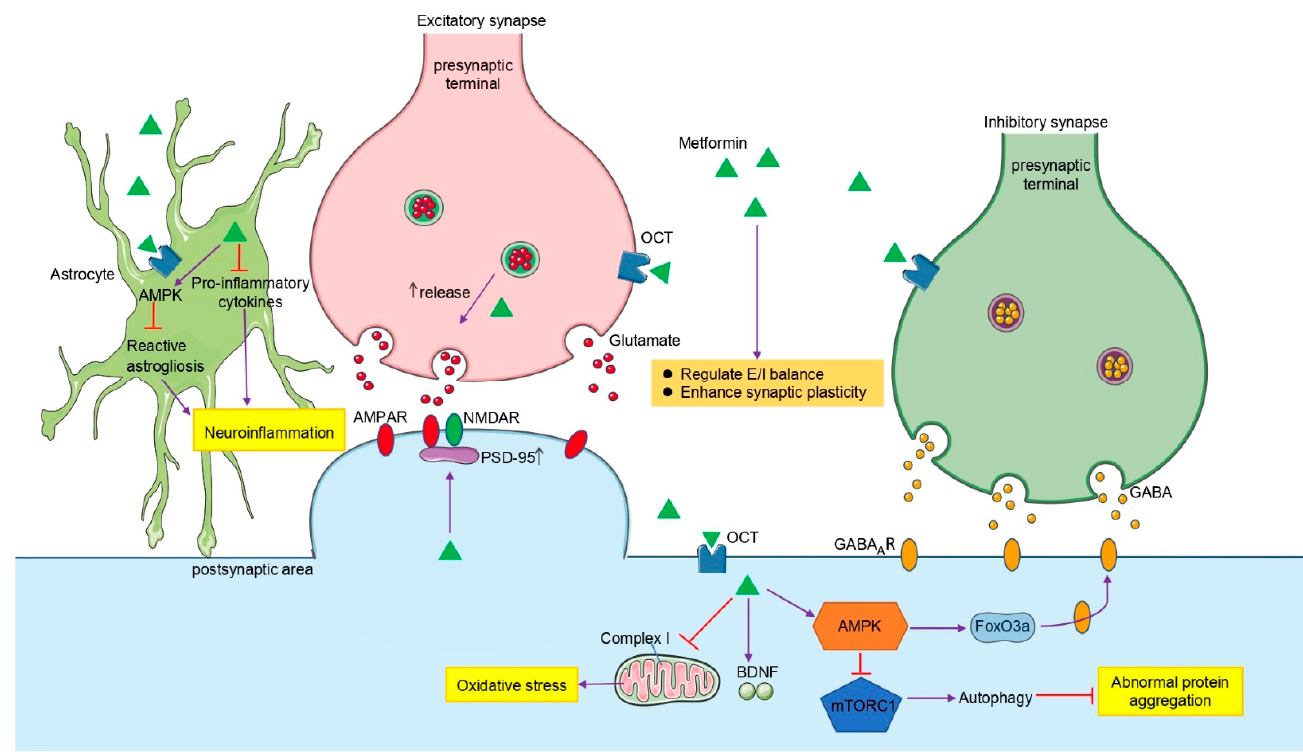
Figure 2. Potential mechanisms underlying the actions of metformin in the brain. In neurons, met- formin regulates autophagy by AMPK/mTORC1 signaling pathway to alleviate abnormal protein aggregation. In addition, metformin decreases oxidative stress by regulating mitochondrial home- ostasis. In astrocytes, metformin suppresses neuroinflammation by inhibiting reactive astrocyte pro- liferation and proinflammatory factors. In synaptic transmission, metformin may regulate E/I bal- ance by directly regulating the amount of presynaptic neurotransmitter release or altering the ex- pression level of receptors on the postsynaptic membrane. Metformin significantly ameliorates syn- aptic morphological defects and enhances synaptic plasticity in a variety of pathological conditions. AMPK, 5’-AMP-activated protein kinase; mTORC1, mechanistic target of rapamycin complex 1; AMPAR, AMPA-type glutamate receptor; NMDAR, NMDA receptors; PSD-95, postsynaptic den- sity protein 95; BDNF, brain-derived neurotrophic factor; FoxO3a, forkhead box O3a; GABA, gamma-aminobutyric acid; GABA A R, GABA type A receptor.